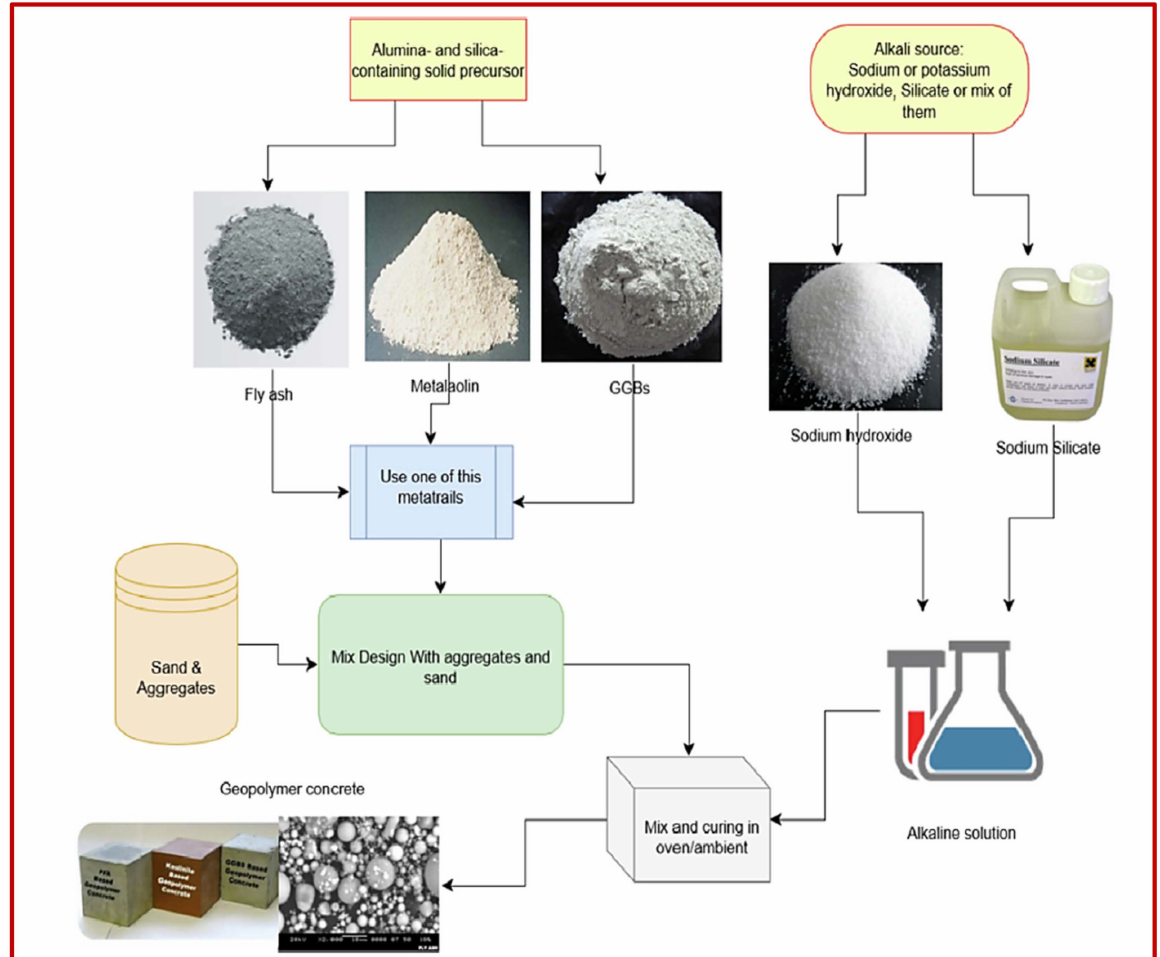
Figure 1. GPC manufacturing; reprinted with permission from